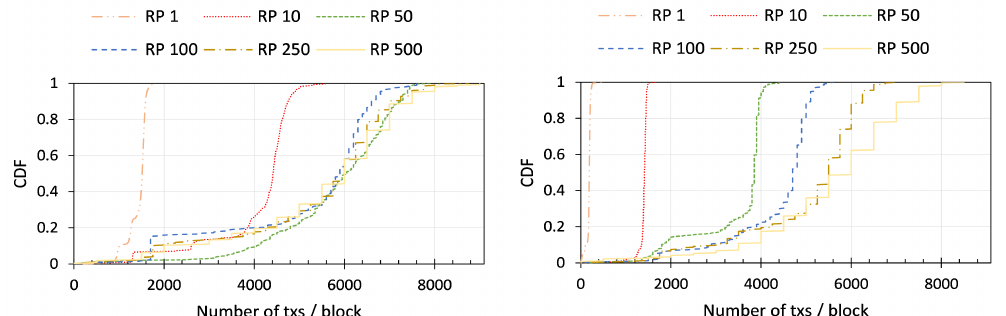
Figure 8. Our benchmarking scenario, as well as the evaluation domain for the Core Engine. The left figure is to assess the overall Core Engine throughput and latency. Meanwhile, the right figure is for the Core Engine priority implementation.